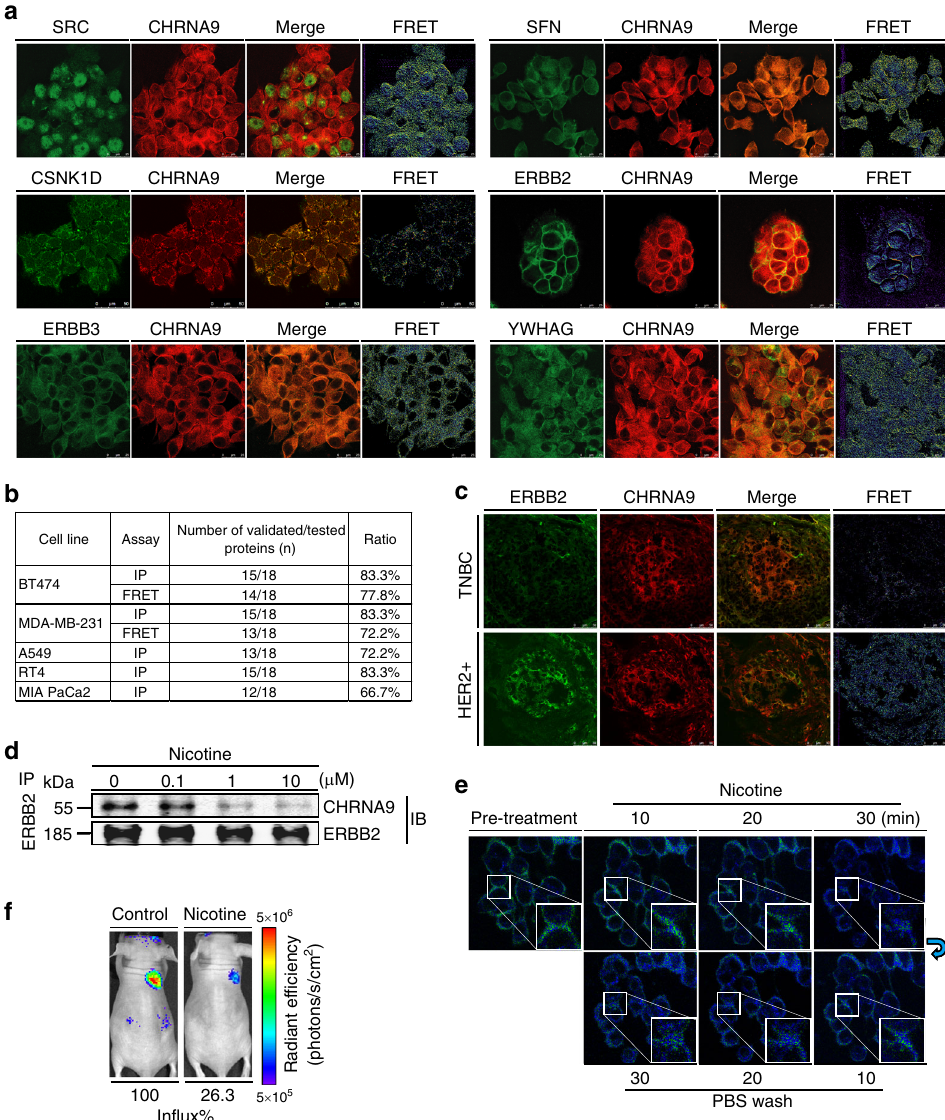
Fig. 6 Identi fi cation of nicotinic acetylcholine receptor subunit α 9 (CHRNA9)-binding partners and CHRNA9/ERBB2 interaction changes. a Identi fi cation of proteins interacting with CHRNA9 by Förster resonance energy transfer (FRET). BT474 cells were hybridized with CHRNA9 and interacting proteins using secondary rhodamine and fl uorescein isothiocyanate (FITC) dyes and then examined under a confocal microscope imaging system via FRET module analysis. The representative photos show strong associations between CHRNA9 and the interacting proteins; the results of other partner candidates are shown in Supplementary Fig. 31. The green/yellow/red colors represent the intensity of FRET ef fi ciency. b Validation ratios of the partner candidates associated with CHRNA9 via immunoprecipitation (IP) and FRET analyses. c The clinical breast tumors of triple-negative breast cancer and HER2-enriched subtypes with CHRNA9/ERBB2 interactions were analyzed by FRET. d Dissociation between CHRNA9 and ERBB2 under nicotine dose-dependent treatment. An ERBB2 antibody blotting was used as the loading control. Source data are provided as a Source Data fi le. e Fluorescence-lifetime imaging microscopy (FLIM) of the CHRNA9/ERBB2 complex in MDA-MB-231 cells pretreated with 10 μ M nicotine and washed with phosphate-buffered saline. MDA-MB-231 cells were co-transfected with CHRNA9-CFP/ERBB2-YFP 2 days prior to FLIM analysis. The green/blue colors represent the intensity of FRET ef fi ciency. f Split luciferase complementation assay of the CHRNA9/ERBB2 complex in a xenograft animal model before and after 100 µ g kg − 1 nicotine oral treatment, as determined by in vivo imaging system detection. MDA-MB-231 cells were co-transfected with CHRNA9-Cluc/ERBB2-Nluc plasmids before being inoculated into the mammary fat pads of nude mice. Luciferase activity was measured before and after 30 min of nicotine administered orally to the same mouse. The color bar indicates a signal gradient from high (red) to low bioluminescence intensity 231 (72.2%) cells by FRET analysis (Fig. 6b and Supplementary (IP; Supplementary Fig. 30) or Förster resonance energy transfer Table 6; details in Supplementary Note 12). In addition, we also (FRET; Fig. 6a and Supplementary Fig. 31) assays 42 in human cancer cells. The results demonstrated that ≥ 66.7% of the protein illustrated that CHK1, CDK1, and PLK1 were associated with interactions associated with CHRNA9 were identi fi ed in BT474 SLC16A7 in MDA-MB-231 and A549 cancer cells, providing a (83.3%), MDA-MB-231 (83.3%), A549 (72.2%), RT4 (83.3%) and 75% validation ratio among four selected candidates (Supple- MIA PaCa-2 (66.7%) via IP assays; moreover, similar interacting mentary Fig. 32). Next, we observed high protein expression of pro fi les were also discovered in BT474 (77.8%) and MDA-MB- CHRNA9 and ERBB2, having an S SIM = 3.66 and displaying a